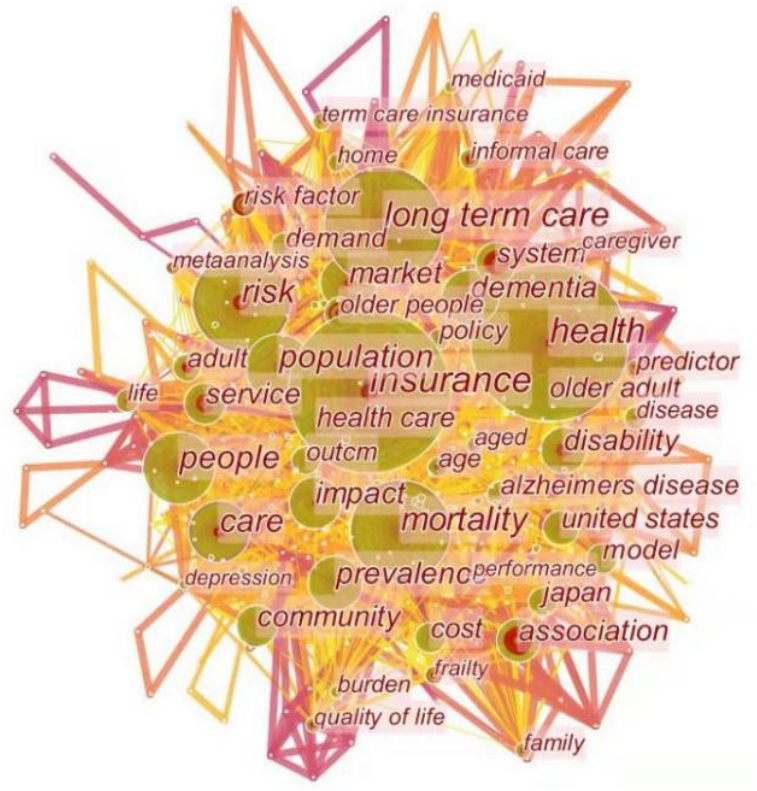
Figure 8. A visualization of the co-occurring keyword network. Table 5. List of 26 representative keywords based on occurrences and